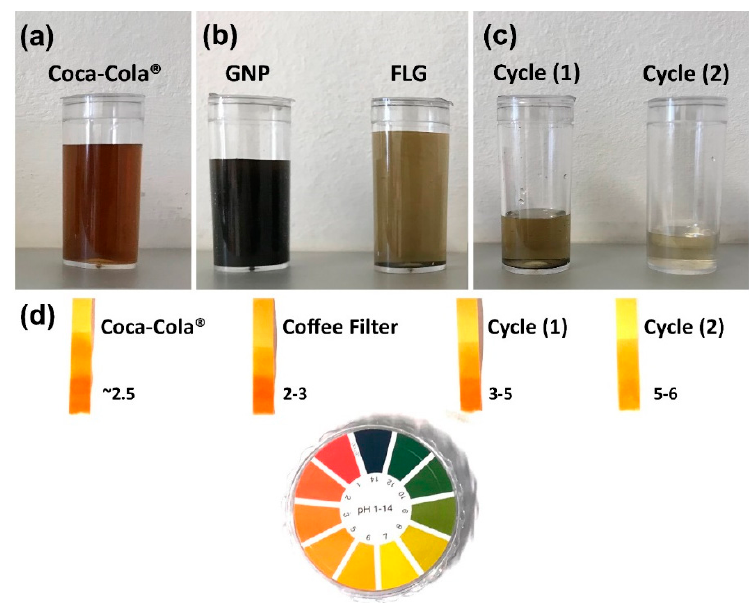
Figure 4. ( a ) Coca-Cola ® filtered only with a coffee filter, ( b ) water-based liquids derived from Coca-Cola ® upon filtration with GNP and FLG powders (first purification cycle), ( c ) water-based liquids derived from Coca-Cola ® following two cycles of filtration with the FLG powder and ( d ) pictures of commercial pH paper strips; from left to right: pure Coca-Cola ® (value extracted from literature [48]), Coca-Cola ® filtered only with a coffee filter and Coca-Cola ® filtered with FLG powder after one and two filtration cycles.